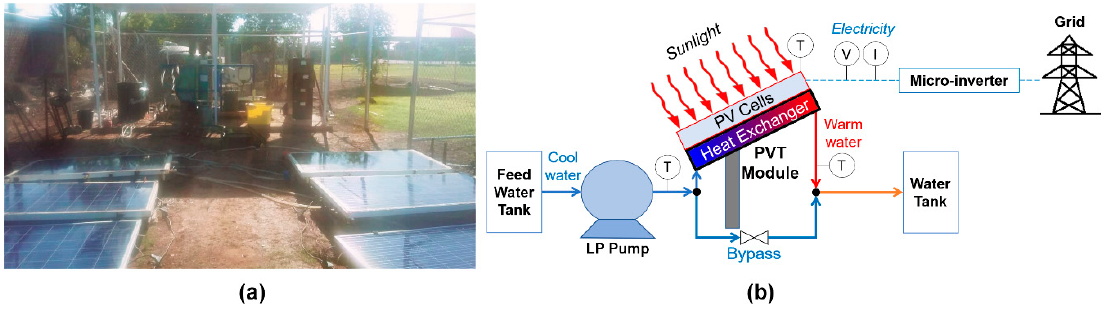
Figure 5. Experimental setup: ( a ) photograph, ( b ) schematic.